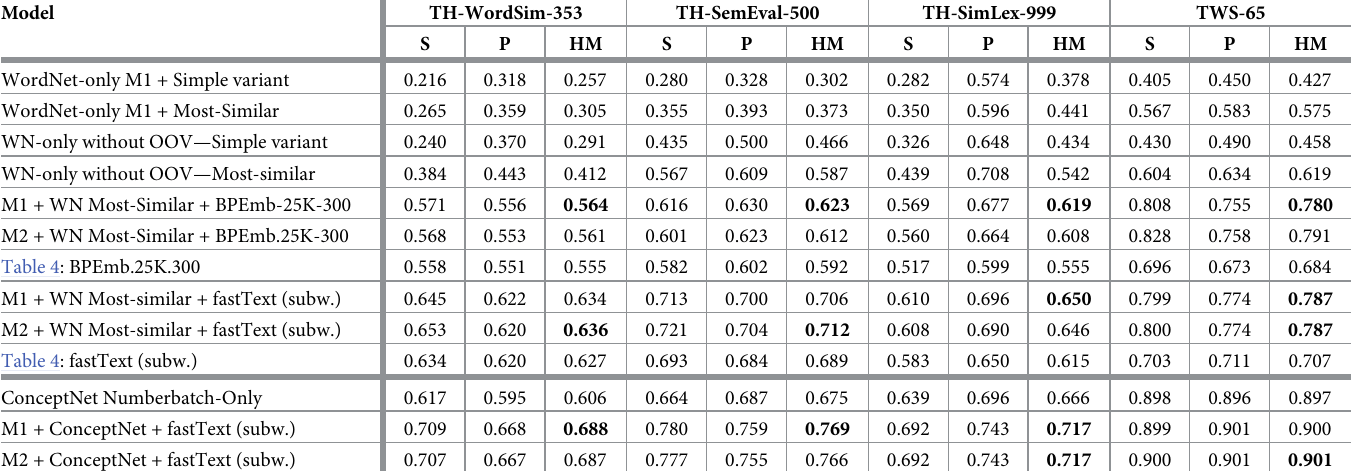
Table 5. Overview of results for combining subword embeddings with structured and hybrid sources (WordNet and ConceptNet Numberbatch). M1 refers to Method 1 from Section Implementation, M2 to Method 2 .